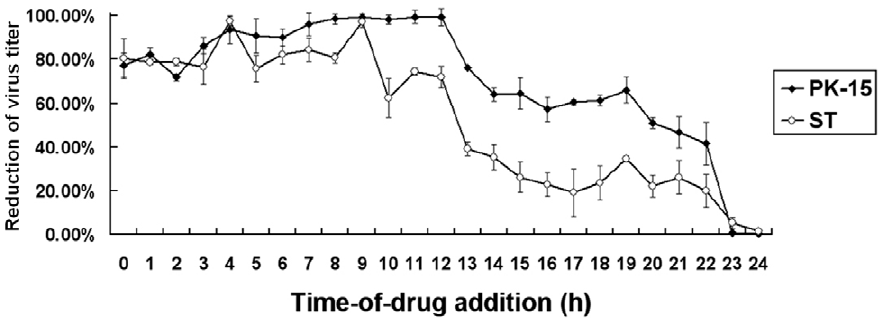
Figure 3. Time-of-addition effect of LiCl on TGEV replication. Cells in 96-well plates were infected with TGEV at an MOI of 30 followed by addition of 25 mM LiCl at the indicated time (hpi). The reduced virus titer was calculated using MTT assays by measuring OD 492 value at 24 h post- infection. The experiment was performed in triplicate.